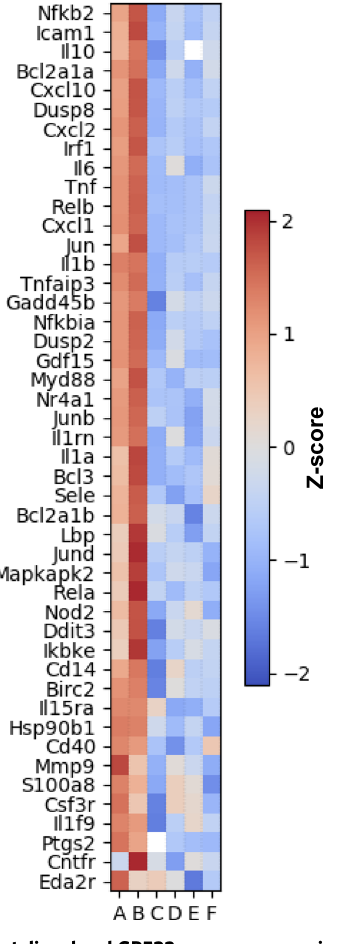
Fig. 9 Effects of entolimod and GP532 on gene expression in mouse liver. RNAseq analysis was performed to identify changes in gene expression in mouse livers collected 30 min after s.c. injection of GP532 (1 μ g/mouse, lanes A and D), entolimod (1 μ g/mouse, lanes B and E) or vehicle (lanes C and F) in wild type (WT) C57BL/6 mice (lanes A, B, C) or TLR5-KO mice (lanes D, E, F). Data were shown as a heatmap for genes from the top fi ve enriched pathways identi fi ed by KEGG pathway analysis: KEGG Pathways mmu04668 (TNF signaling), mmu04657 (IL-17 signaling), mmu04060 (cytokine – cytokine receptor interaction), mmu04010 (MAPK signaling), and mmu04064 (NF-kappa B signaling). These genes were signi fi cantly upregulated (deseq2 log2FC > 0, adjusted P value < 0.05) in WT mice treated with either entolimod or GP532 as compared to a combined group of vehicle-treated WT mice and all TLR5-KO mice (vehicle-, entolimod-, and GP532-treated). Data were analyzed using deSeq2 R software. deseq2 normalized counts were log2-transformed and Z -score values were calculated independently for each gene (exact zero values were excluded and are shown as white squares). Genes were sorted using an unweighted pair group method with arithmetic mean (UPGMA) hierarchical clustering algorithm. The red-blue colored heatmap shows Z -scores ranging from 2 to − 2 as indicated by the vertical bar on the right of the fi